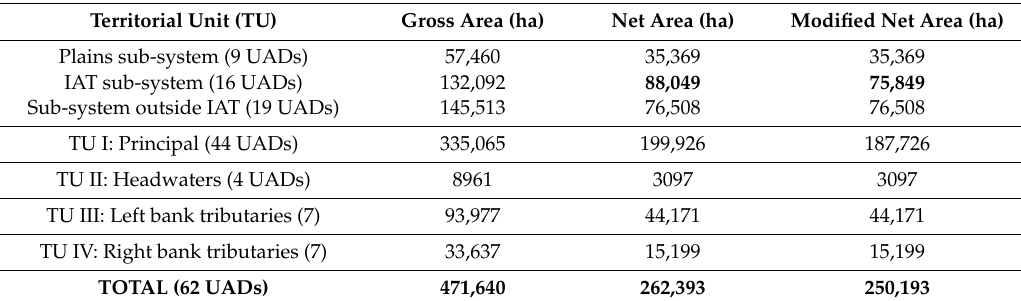
Table 2. Modification of the net area in the irrigated areas of the transfer (IAT) sub-system Source: